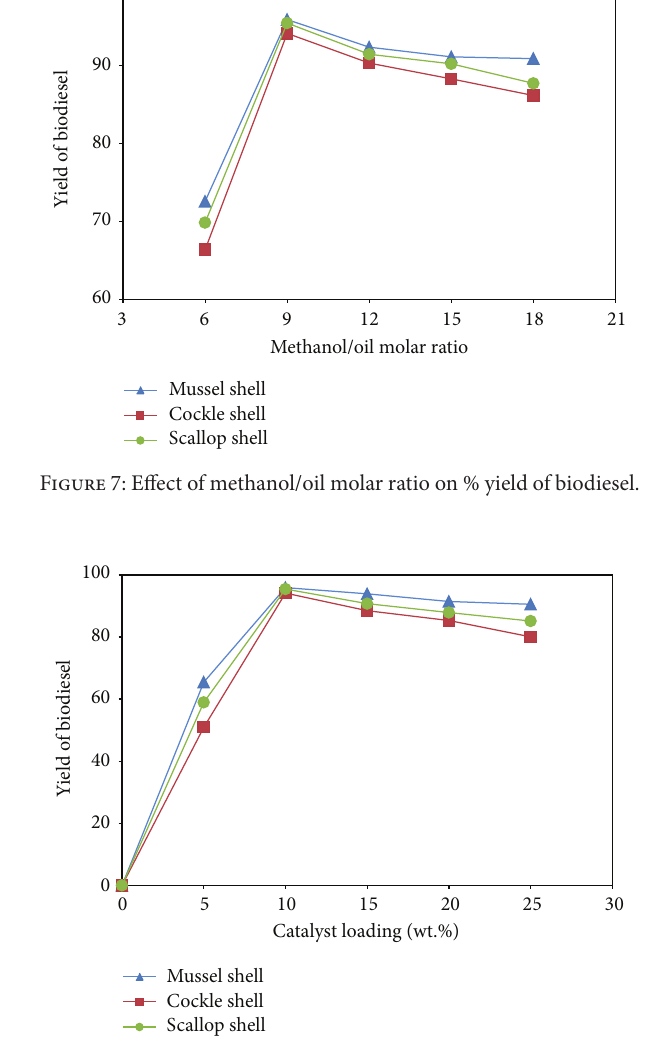
Figure 8: Effect of catalyst loading on % yield of